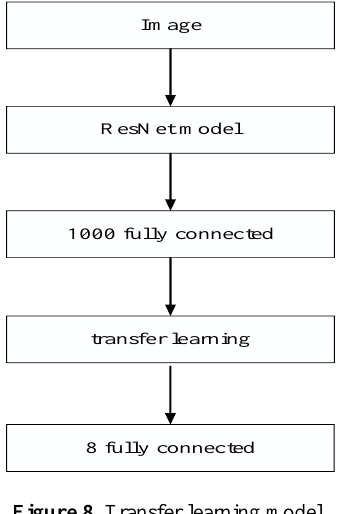
Figure 8 . Transfer learning model.